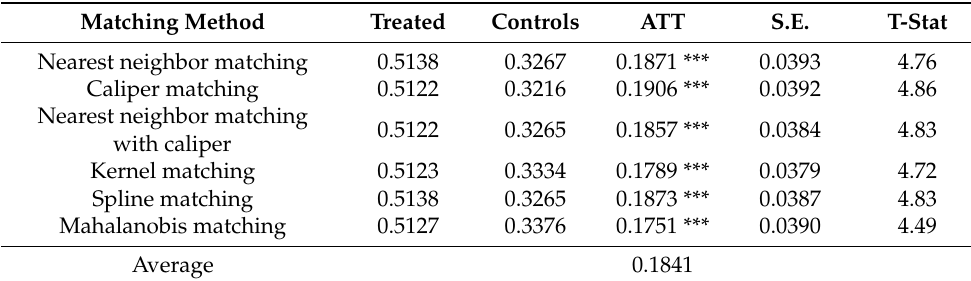
Table 3. The effect of formal credit participation on e-commerce utilization.